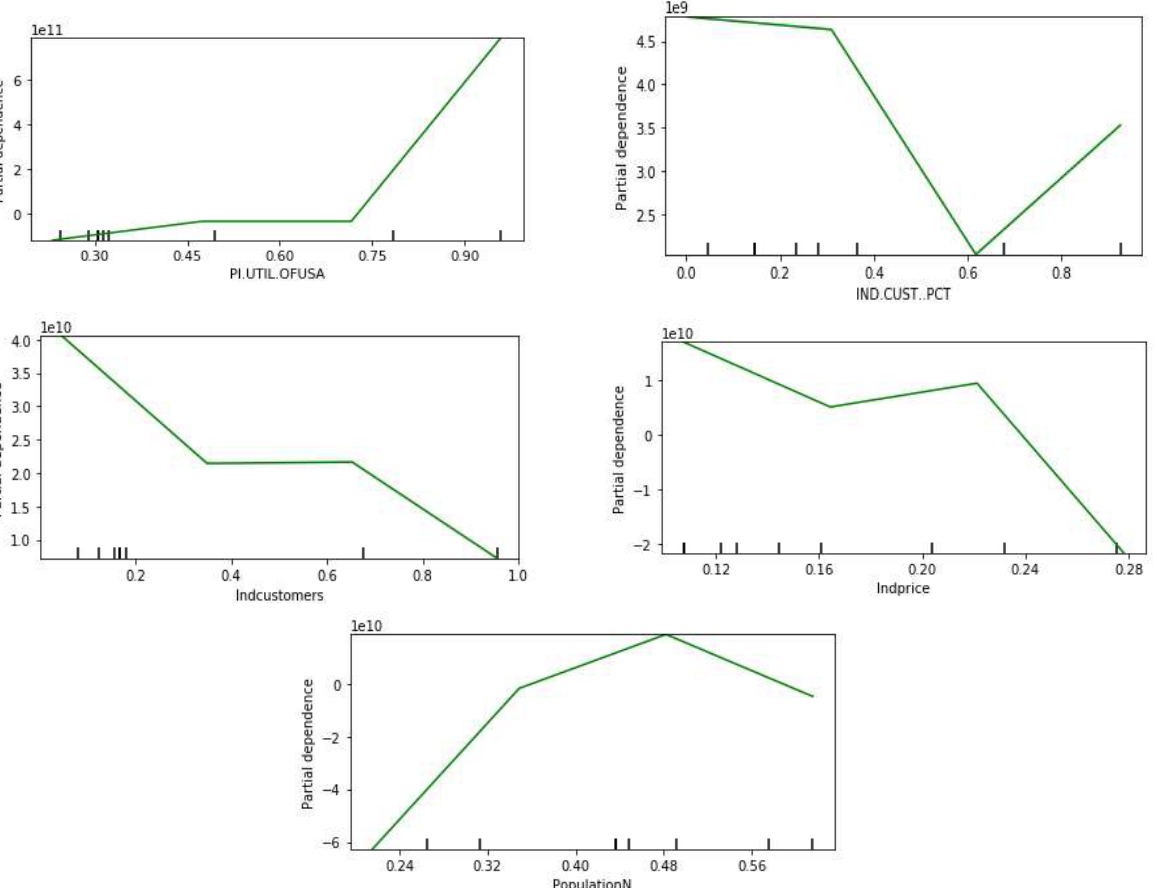
Figure 12. Partial dependency plots of top five important parameters for revenue loss prediction in the hurricane disaster category. the hurricane disaster category.